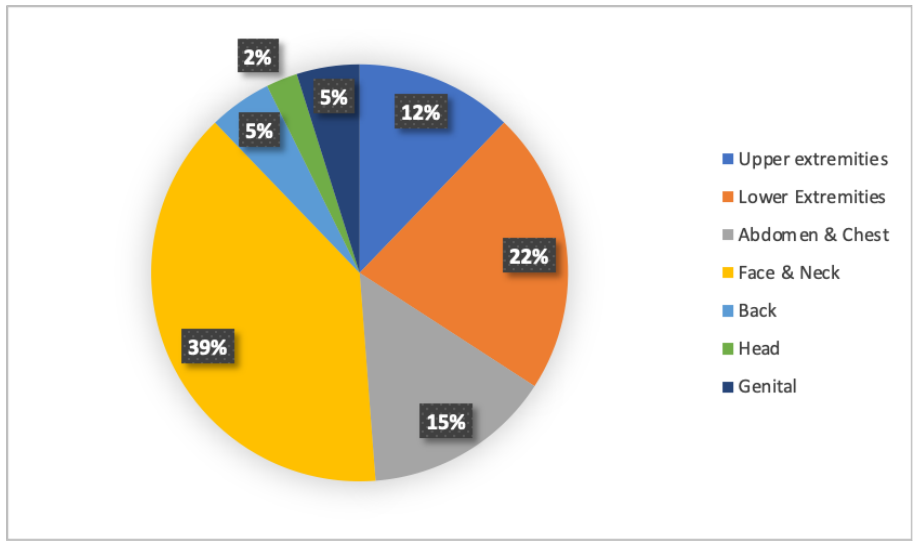
Figure 4. Anatomical locations of pediatric burns among patients. Table 2. Features of the